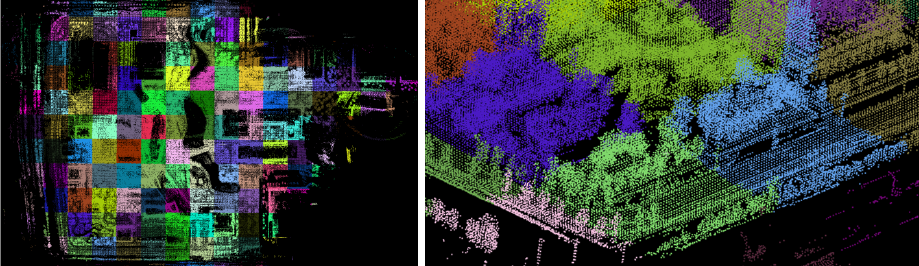
Figure 16. Map segmentation result: global ( left ) and local ( right ) perspectives.